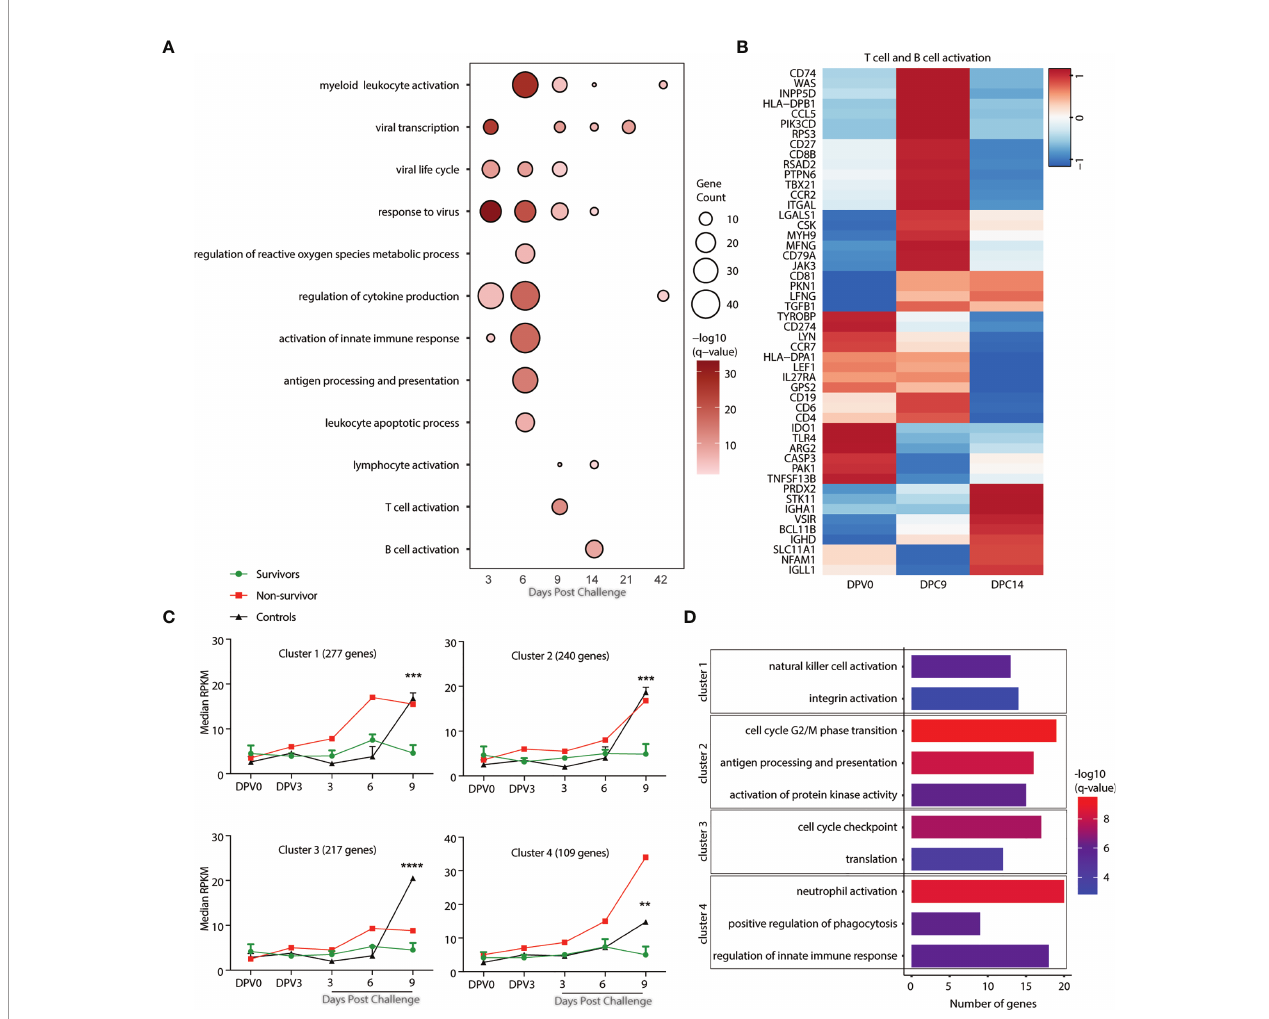
FIGURE 5 | Gene signatures of fatality versus survival in animals vaccinated 3 days before challenge. (A) Functional enrichment of DEGs post VSV-MARV challenge day -3 group; each bubble represents a Gene Ontology (GO) term, and the size of each bubble represents number of DEGs enriching to that GO terms while color intensity represents the statistical signi fi cance (shown as – log 10 of the q-corrected p-value). (B) Heatmap of DEGs detected post challenge in the day -3 group enriching to “ T cell activation ” , and “ B cell activation. ” Each column represents the median normalized transcript counts (RPKM) for each gene at each time point. The range of colors is based on scaled and centered RPKM values of the entire set of genes, with red indicating highly expressed genes and blue indicating lowly expressed genes. (C) maSigPro analysis identi fi ed four distinct and signi fi cant temporal expression clusters of genes between survivor and non-survivor animals. The median RPKM of each cluster over time is plotted. Statistical signi fi cance among time points was determined using one-way ANOVA with Dunnett ’ s multiple- comparison test relative to 0 DPV. Statistical signi fi cance is indicated as ****p < 0.0001, ***p < 0.001, and **p < 0.01. (D) Functional enrichment of the four clusters presented in panel (C). Horizontal bars represent the number of genes mapping to each GO term with color intensity representing the negative log of the FDR- adjusted p-value